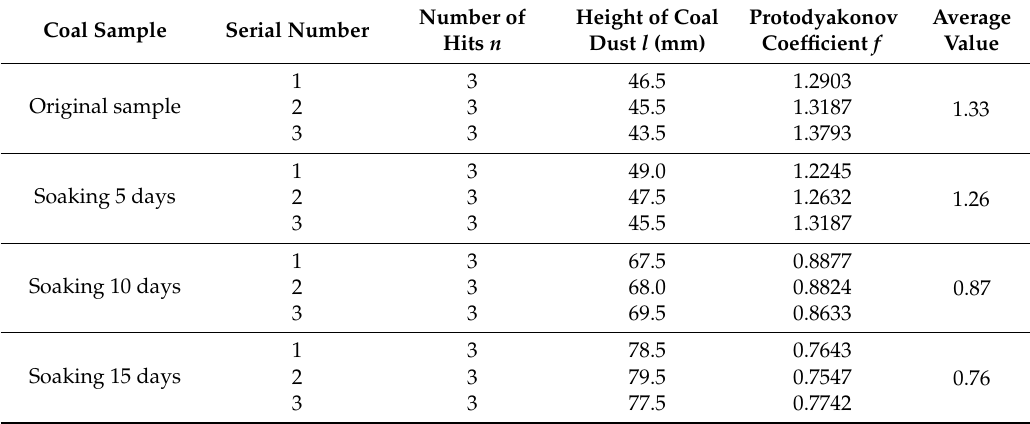
Table 1. Test results of Protodyakonov